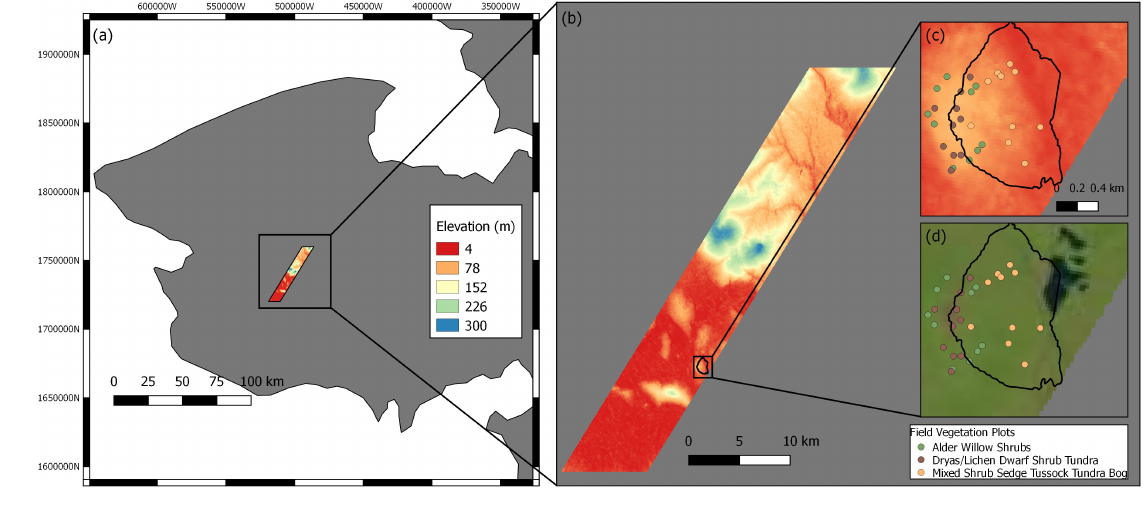
Figure 1. DEM over the study area located on the Seward Peninsula ( a ), shown in the right panel ( b ) is the study area showing the Kougarok watershed (black boundary). The Kougarok watershed is shown with the field vegetation plot locations (colored circles) with the DEM ( c ) and Landsat 8 OLI true color image ( d